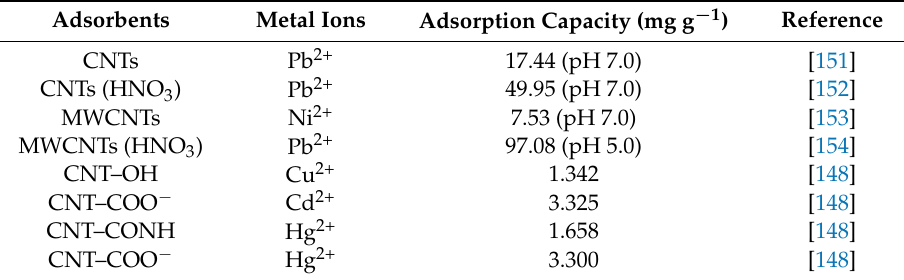
Table 2. Adsorption of heavy metal ions onto different types of